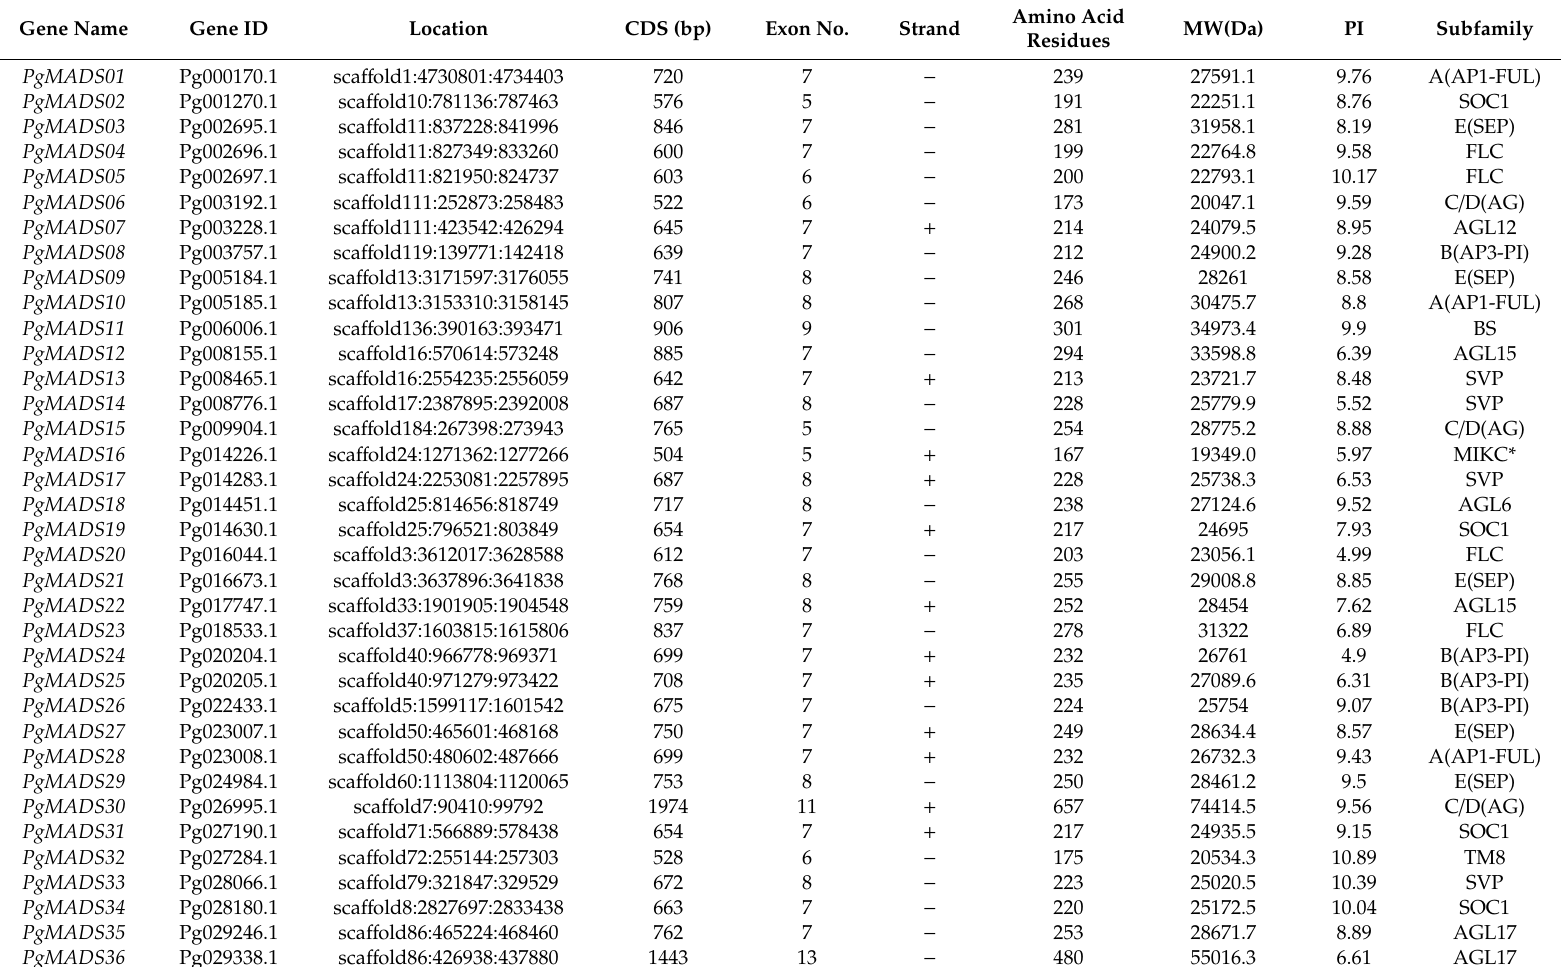
Table 1. The basic information of the pomegranate MIKC-type MADS-box gene